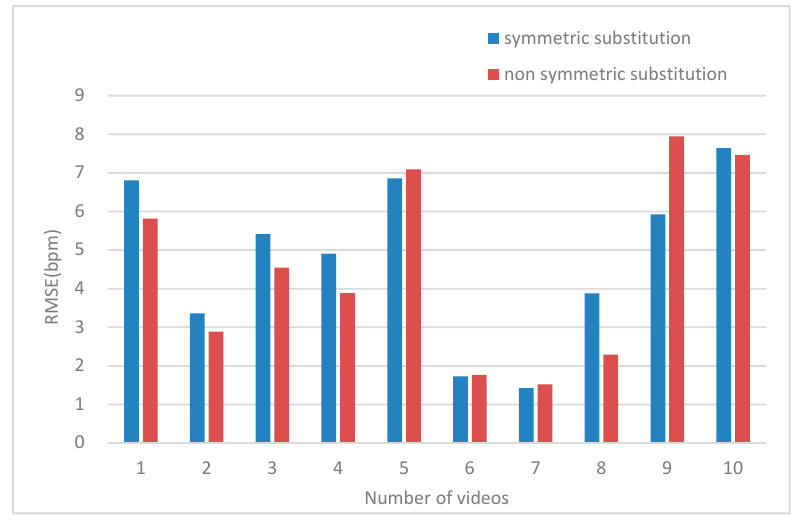
Figure 7. Comparison of the effect of the symmetrical substitution method in the band region. Furthermore, we compared the e ff ects of using the symmetric substitution method and not using